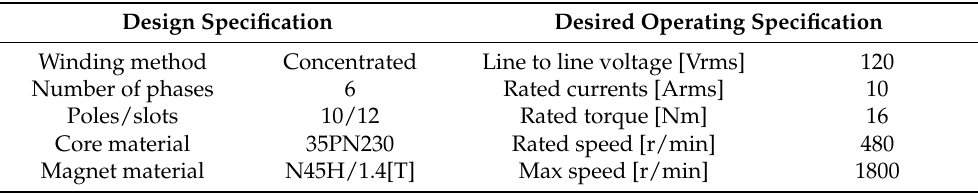
Table 2. Design specifications of a six-phase PMSM. Figure 5. Cross-section of designed six-phase PMSM.